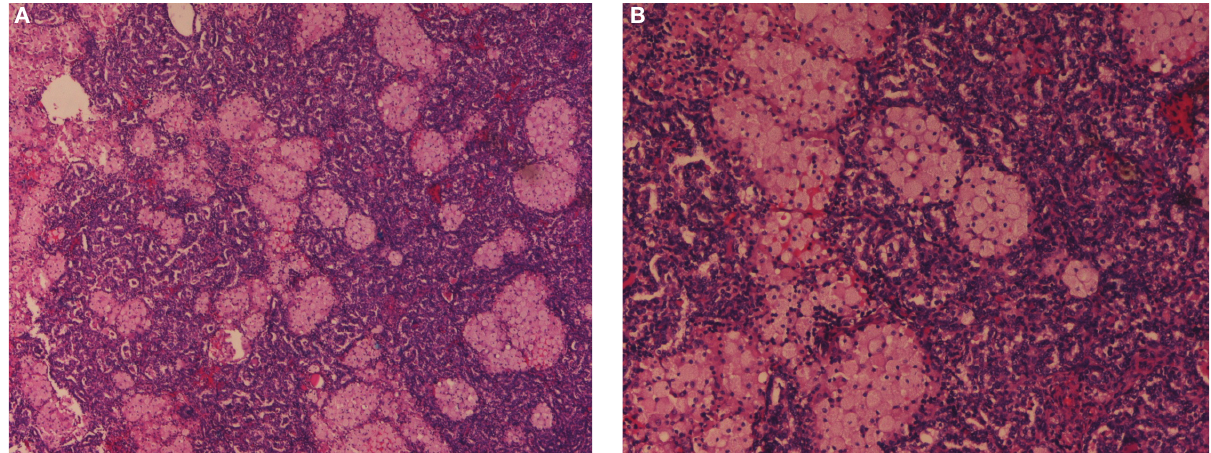
Figure 2. (A) Histopathology showing focal areas of lipid-laden “foamy” macrophages accompanied by neutrophils, lympho- cytes, and plasma cells (hematoxylin and eosin, 100x). (B) High power of Figure A (400x).